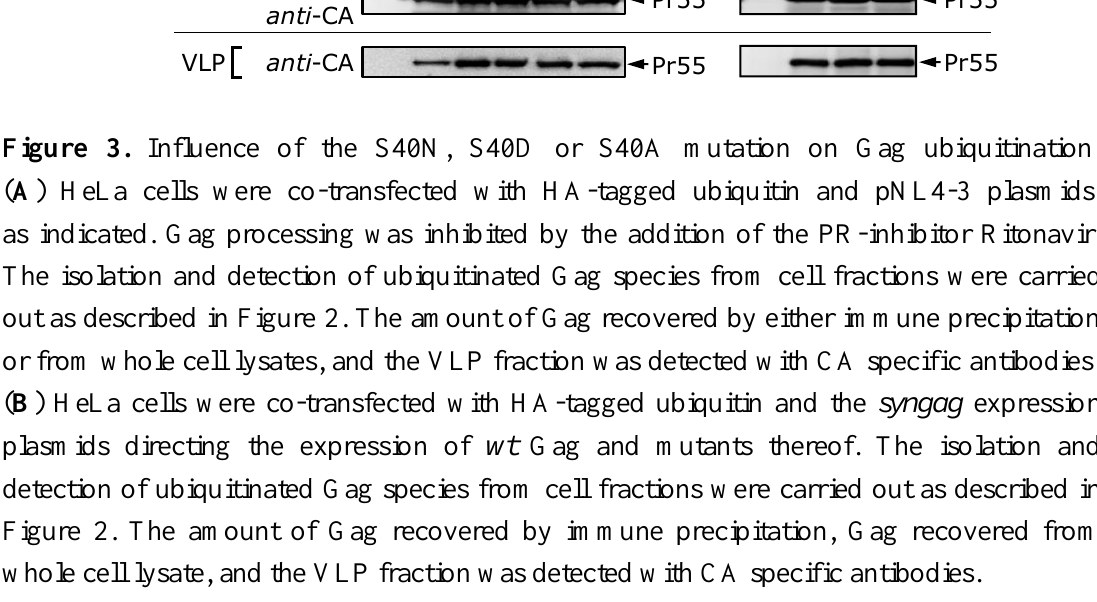
Figure 2. The amount of Gag recovered by immune precipitation, Gag recovered from whole cell lysate, and the VLP fraction was detected with CA specific